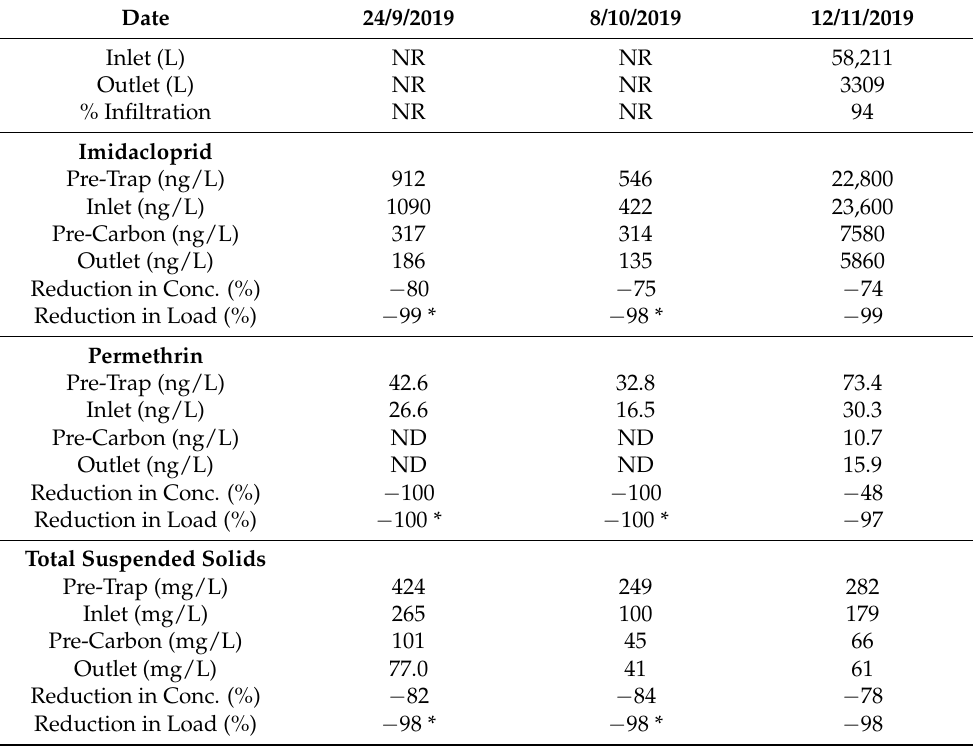
Table 3. Inflow and outflow water volumes for the 12 November trial, as well as insecticide and total suspended solid concentrations, and relative concentration and load reductions for all trials.